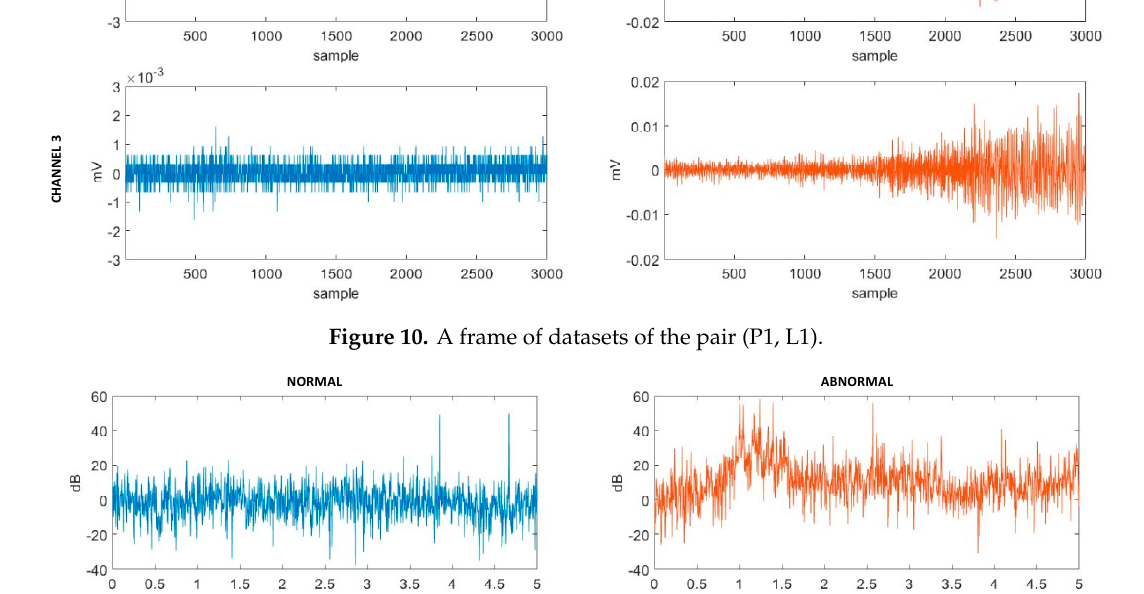
Figure 11. A frame of g ( r ) for datasets of the pair (P1, L1).